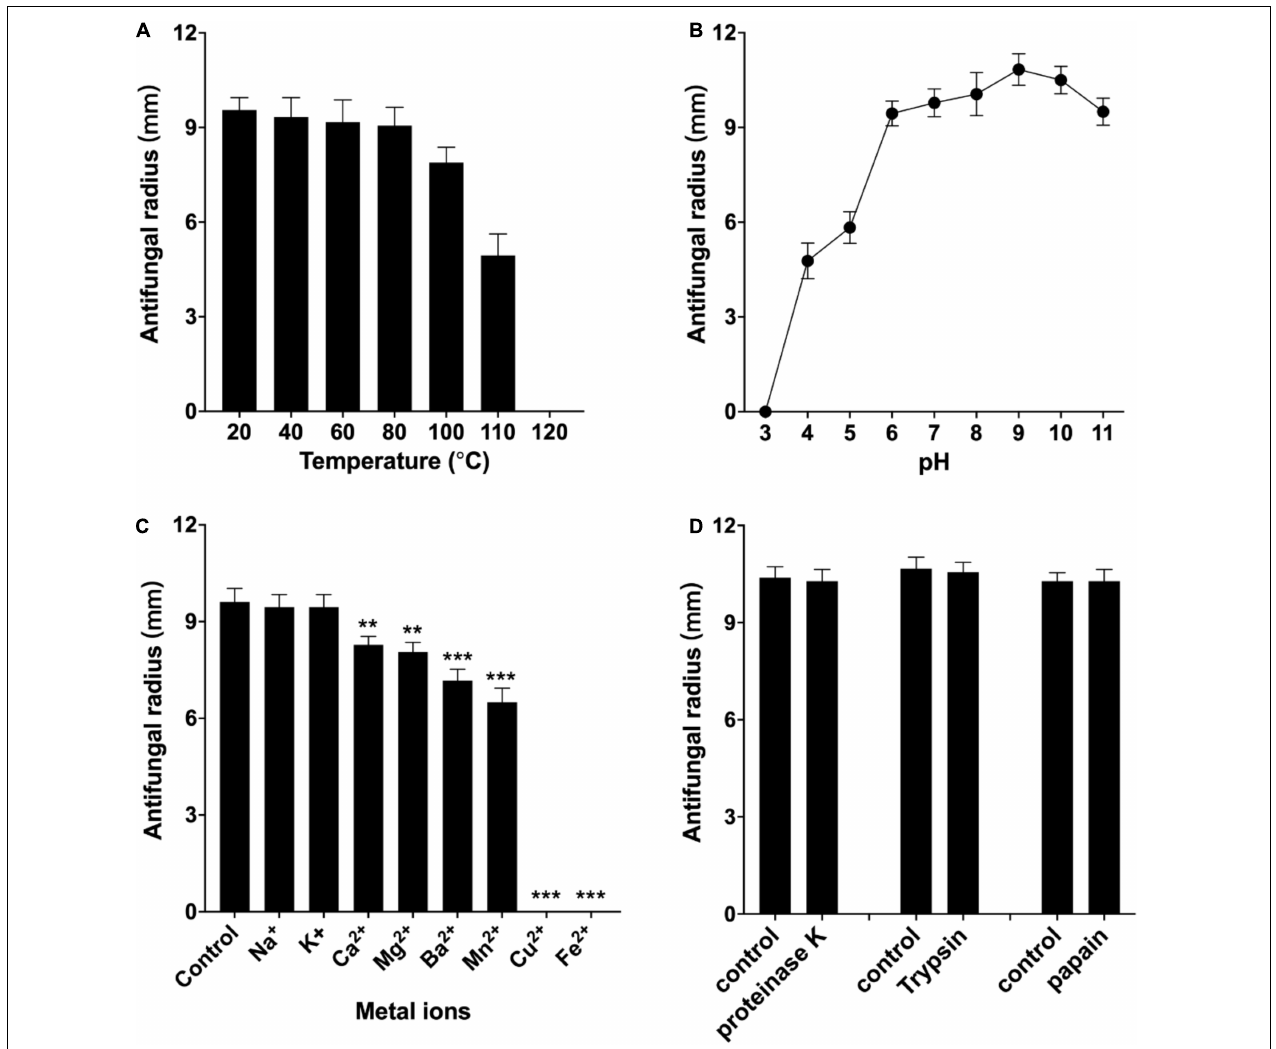
FIGURE 7 | Effect of temperature (A) , pH (B) , metal ions (C) , and proteases (D) on antifungal activity of the purified peptide W1 against F. oxysporum . The purified W1 with a concentration of 160 µ g/ml was used in all assays, which were repeated three times independently. The results are presented as mean ± SD, and representative images are shown. ** p < 0.01, *** p < 0.001 vs. normal